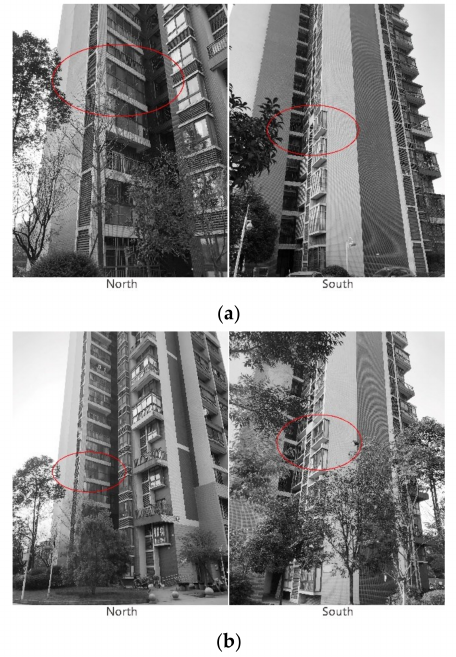
Figure 5. Overview of the selected residences: original unit ( a ) and renovated unit ( b